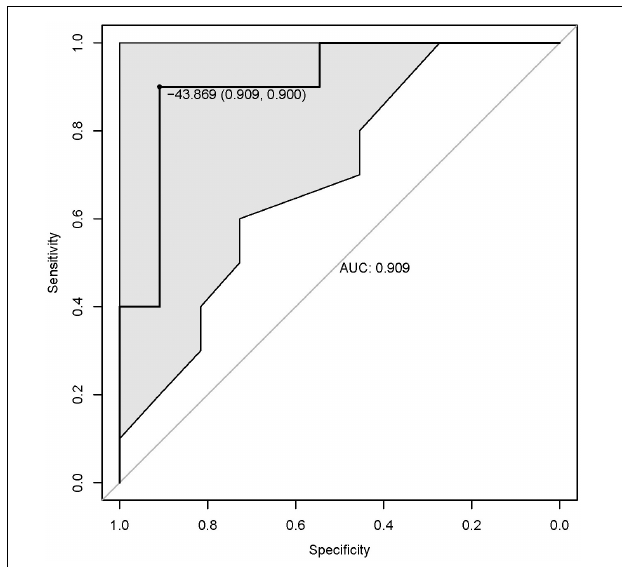
FIGURE 2 | The ROC curve of the polygenic risk score. ROC, receiver operator characteristics; AUC, area under curve. Shadow area represents the 95% confidence interval. The dot in the curve represents the optimal cutoff point and the corresponding specificity and sensitivity (parentheses).